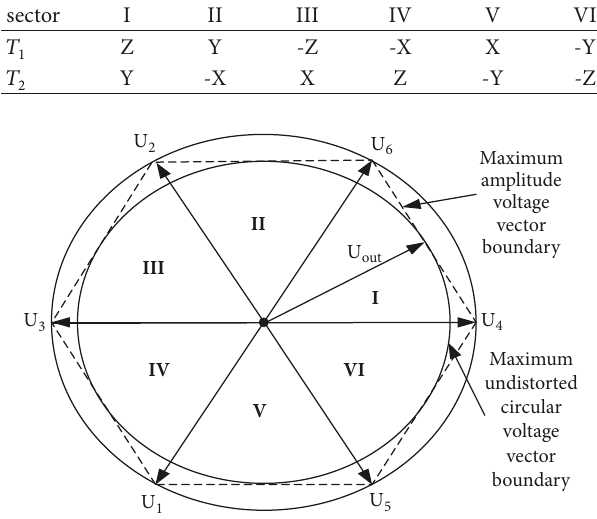
Figure 10: Voltage vector amplitude boundary in SVPWM mode.